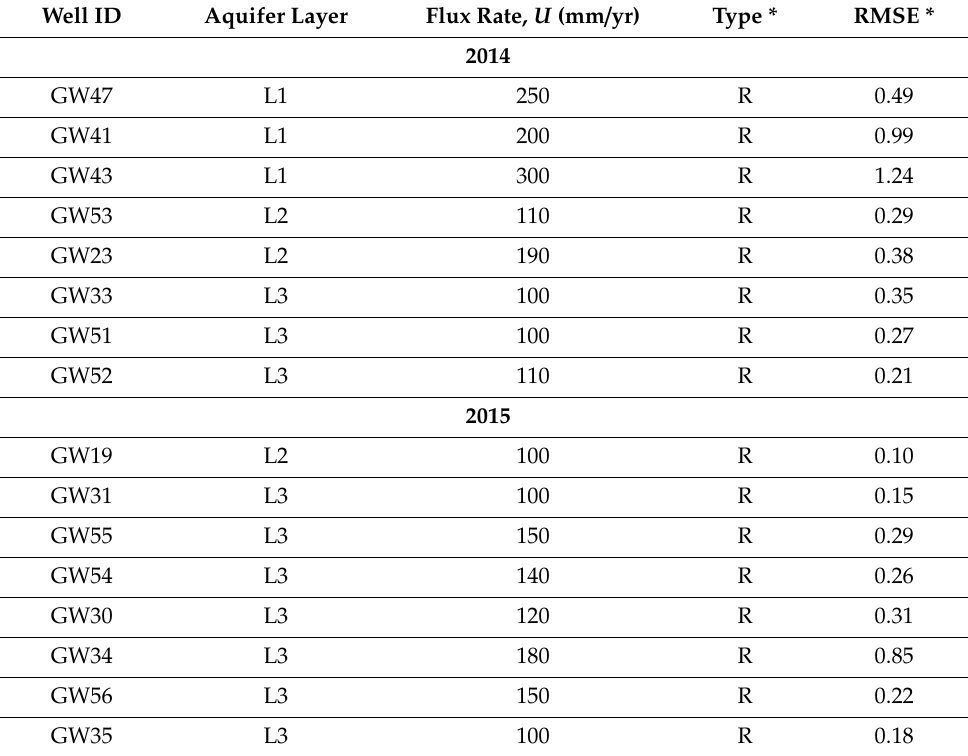
Table 4. Groundwater recharge estimated using TDP